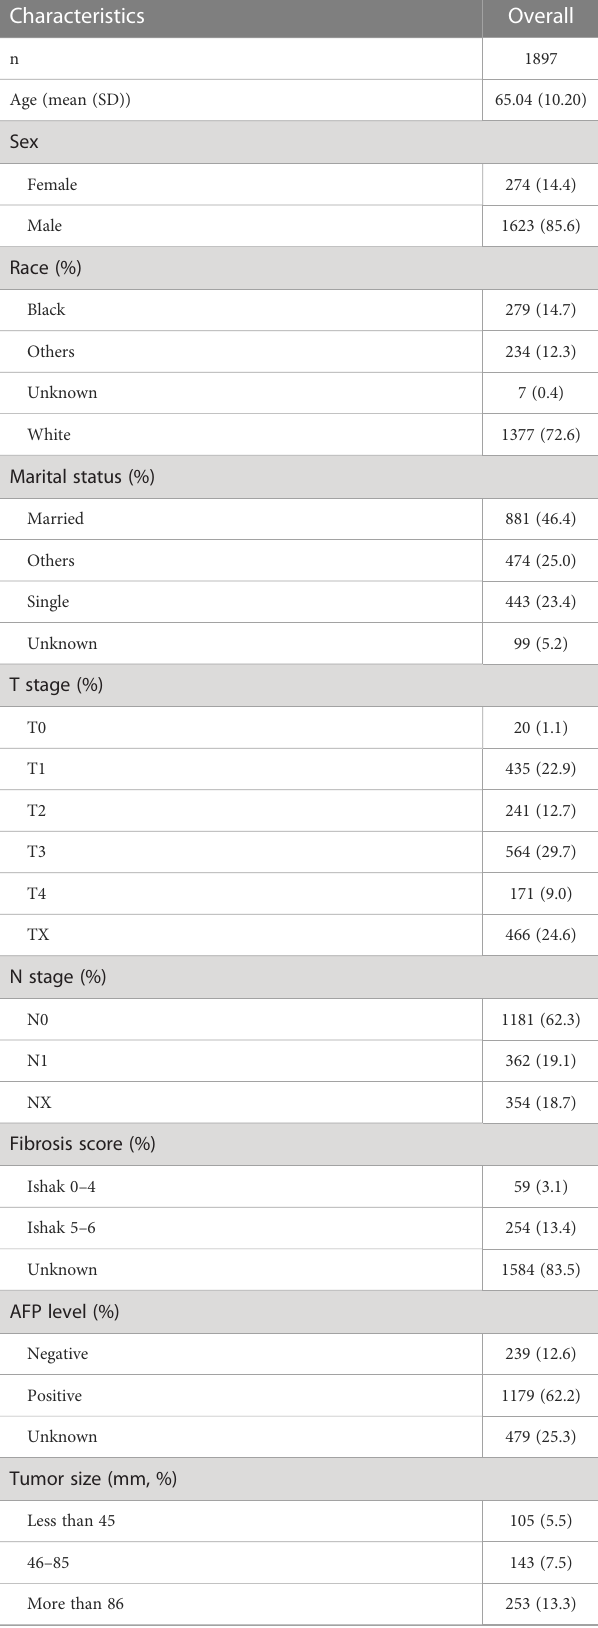
TABLE 1 Baseline clinical characteristics of the entire